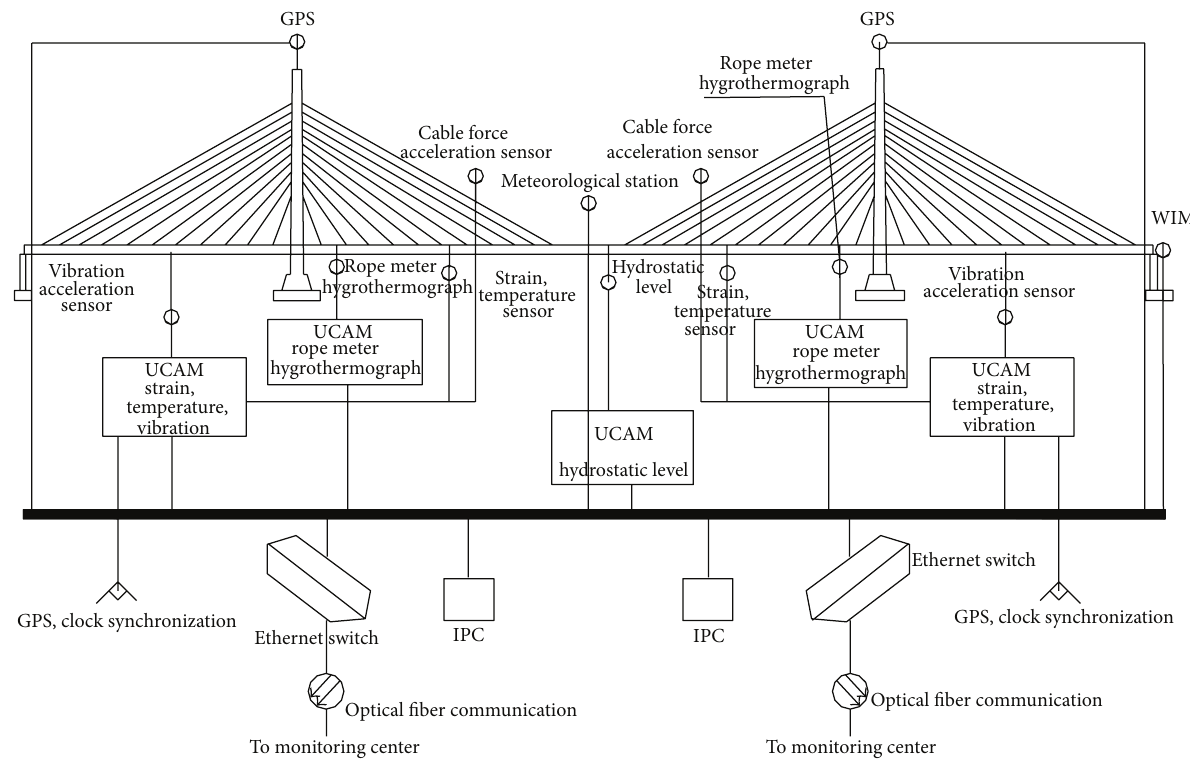
Figure 14: Flowchart of data acquisition and transmission.